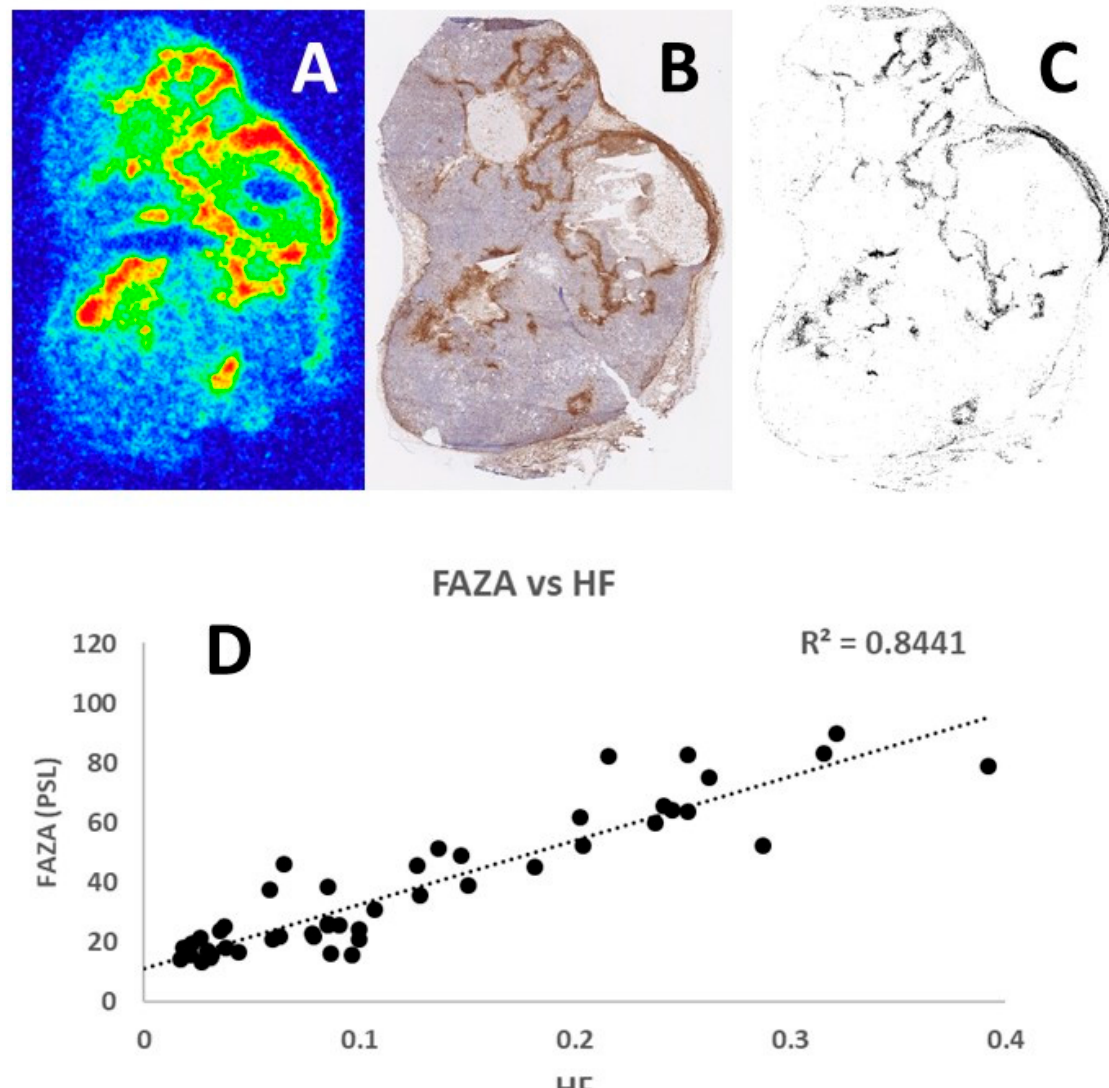
Figure 2. [18F]-FAZA autoradiogram ( A ) and corresponding raw ( B ) and segmented ( C ) pimonidazole staining of the same section (each image is approximately three times larger than the original tumor section), showing that the two hypoxia markers distribute similarly. This was further verified by assessing the spatial relationship between FAZA signal intensity (PSL) and hypoxic fraction (HF), which is derived by placing a grid consisting of 1 mm 2 squares covering the autoradiogram and the segmented pimonidazole image. Only squares within the tumor periphery and largely free of necrosis were used in the final analysis. ( D ) The resulting correlation between FAZA signal and HF.